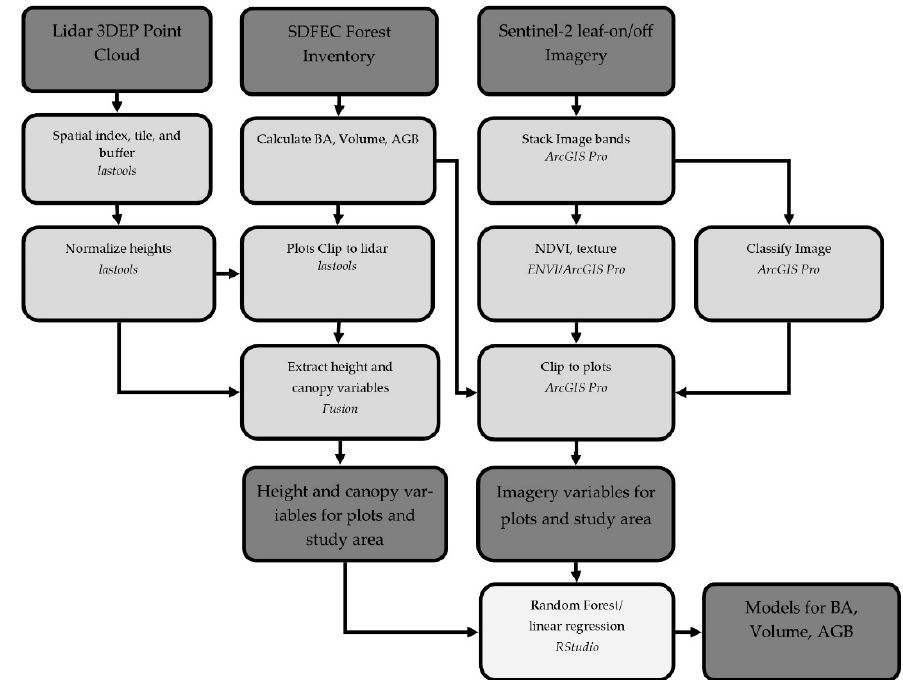
Figure 2. Data processing workflow.